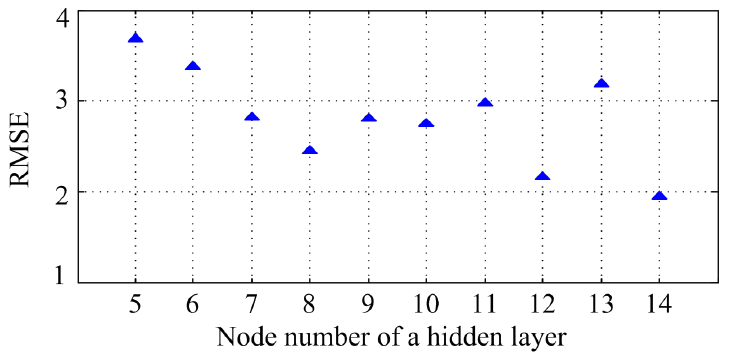
Figure 6. RMSE versus node number of a hidden